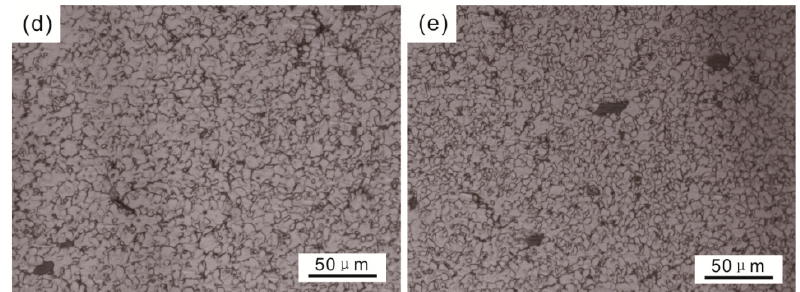
Figure 3. Metallographic diagram of Ta-W alloys under different mass fractions( a ) Pure Ta, ( b ) Ta- 2.5 wt%W, ( c ) Ta-5 wt%W, ( d ) Ta-7.5 wt%W, ( e ) Ta-10 wt%W. wt%W, ( c ) Ta-5 wt%W, ( d ) Ta-7.5 wt%W, ( e ) Ta-10 wt%W.